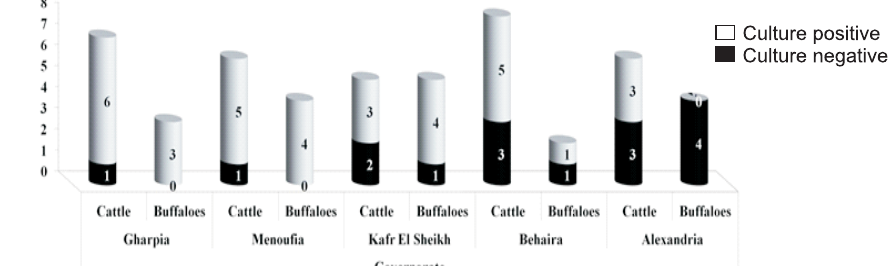
Figure-2: Bacterial culture results on HEYM of pooled fecal samples from cattle and buffaloes present in 5 governorates throughout Egypt. The numbers of positivity in each animal breed of each governorate were indicated.